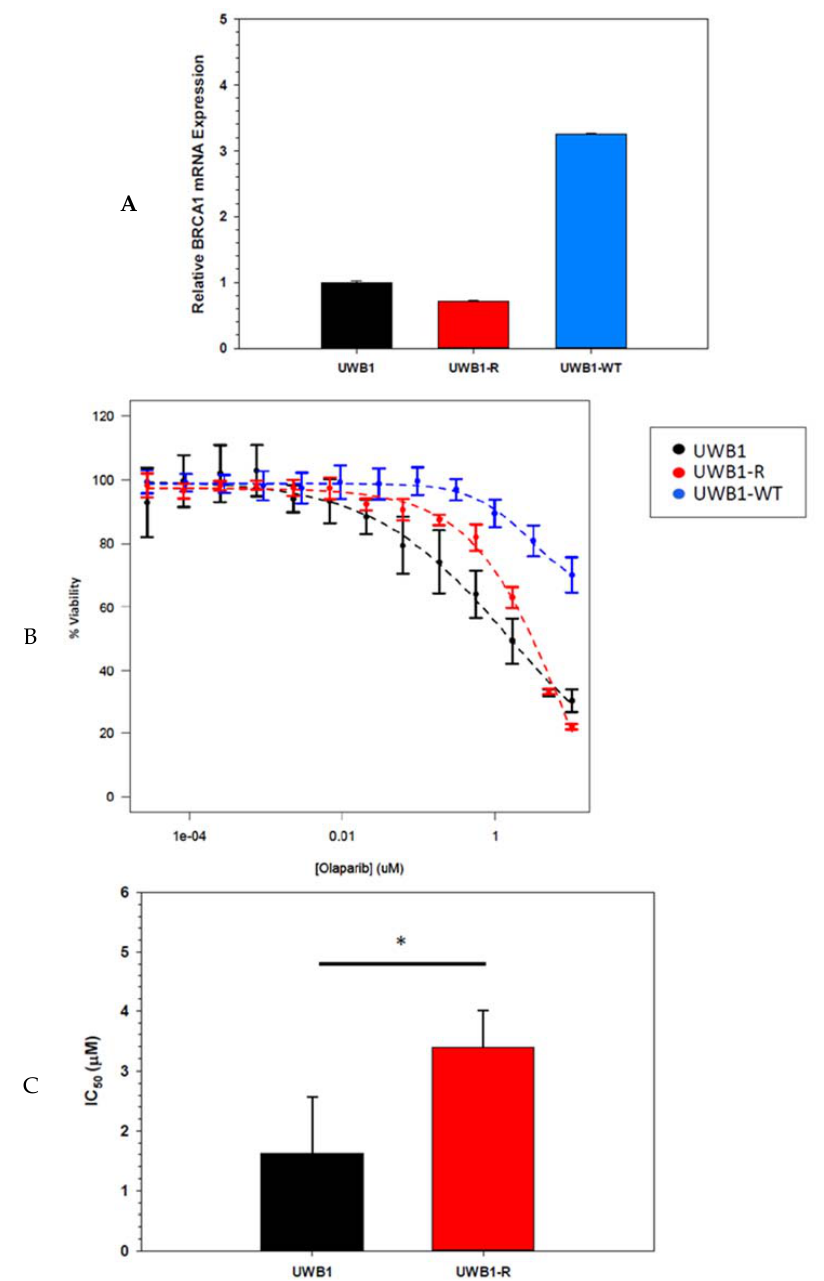
Figure 1. ( A ) Total RNA was extracted from UWB1, UWB1 ‐ R and UWB1 ‐ WT cell lines. mRNA expression of BRCA1 is shown relative to UWB1 cell line. Quantification of RNA levels relative to UWB1 were calculated by the Livak method using the QuantStudio PCR software analysis. Experiments run in triplication with standard deviation error bars shown. ( B ) Cell viability assay shown for olaparib ‐ treated cells. Cells were treated in olaparib ‐ containing media for 144 h at increasing doses and the dose ‐ response plotted to estimate the IC 50 . Experiments were run in triplicate with standard deviation error bars shown. ( C ) Estimated IC 50 comparing UWB1 (1.6 ± 0.9 μ M) versus UWB1 ‐ R (3.4 ± 0.6 μ M) and was statistically significant ( α < 0.05). UWB1 ‐ WT cells were highly resistant to olaparib treatment with an IC 50 was not attained in our (>10 μ M). Plotted are the individual means with standard deviation error bars shown. α ≤ 0.05 = *.